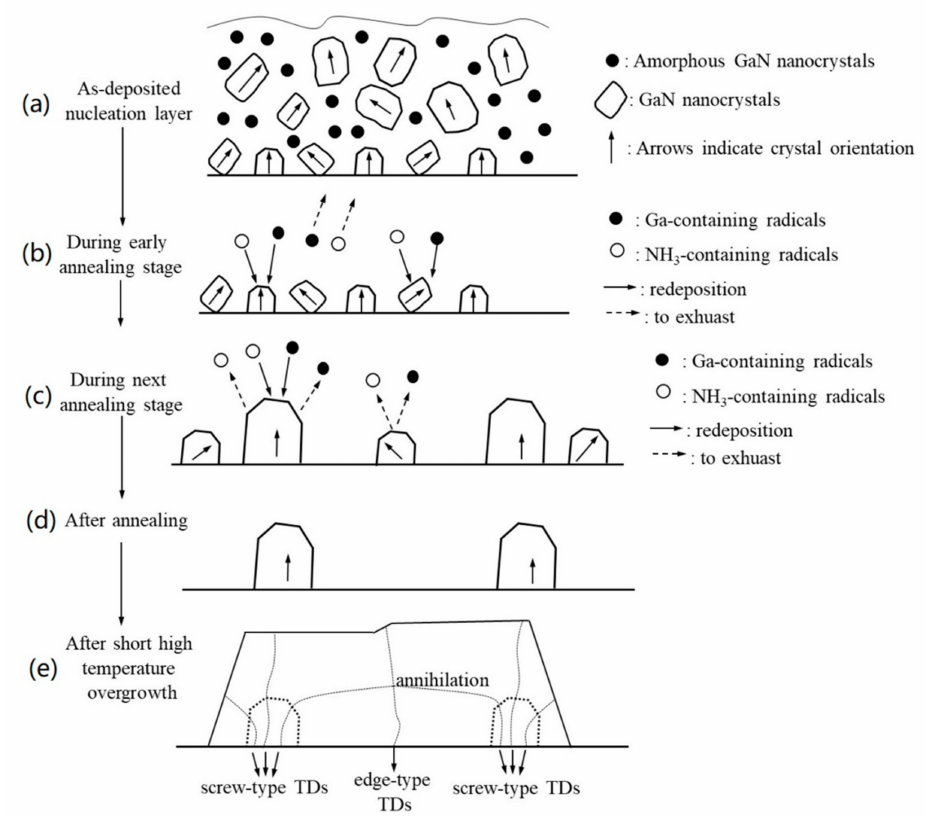
Figure 8. Schematic illustrating structure evolution of GaN nucleation, annealing and 3D growth. ( a ) is the as-deposited nucleation layer; ( b ) is during early annealing stage; ( c ) is during next annealing stage; ( d ) is after annealing stage; ( e ) is during high temperature overgrowth